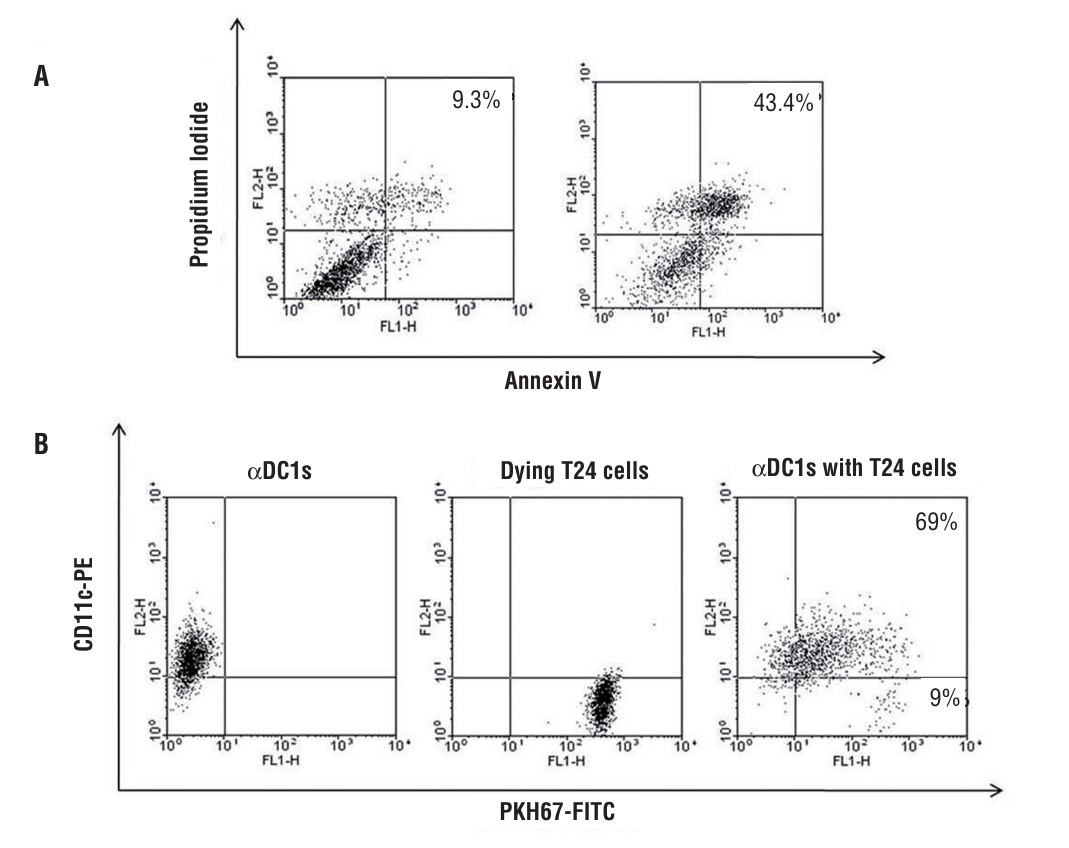
figure 1- A)Both Annexin-v positive/pI negative cells and Annexin-v/pI double-positive cells were considered to be dying cells;B) After co-culturing, the tumor antigen uptake of the α Dc1s was measured by the percentage of double-positive cells. Data are from one representative experiment out of five independent experiments (Data from all cases are provided in supplemental figures 1 Asupl, Bsupl and